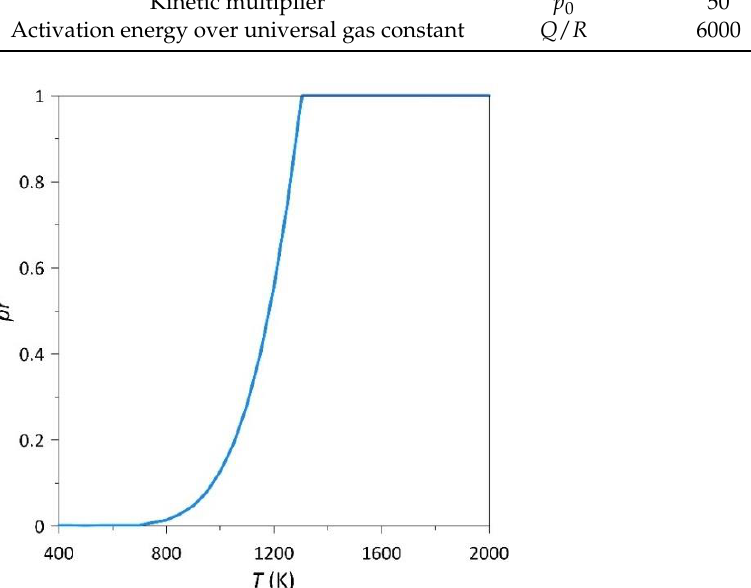
Figure 1. Variation of the new orientation selection probability with temperature, as considered for the simulations of polycrystalline microstructures.